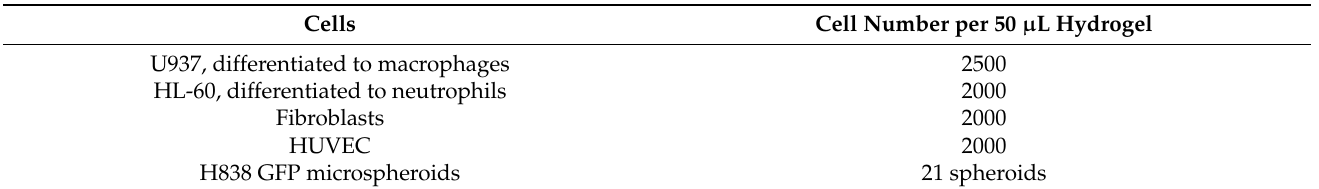
Table 3. Optimal cell numbers to integrate into the miniaturized hydrogel in a total volume of 50 µL.